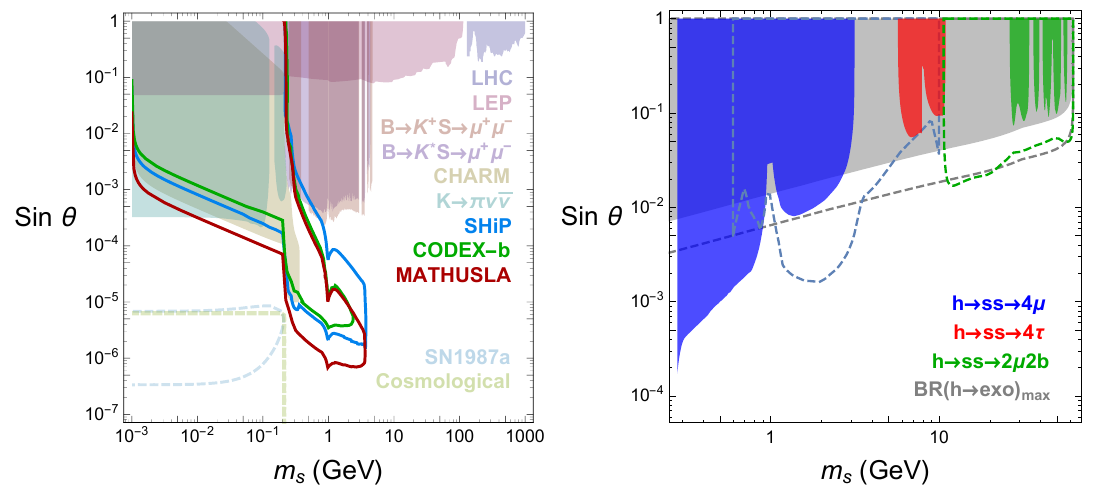
Figure 10 . Left: summary of the current constraints on a dark Higgs portal scalar, s , from: direct searches for heavy scalars decaying to dibosons at LHC [112{114] (blue-gray); Higgs searches at LEP [115{117] (maroon); B + ! K + ( s ! (cid:22) + (cid:22) (cid:0) ) [118] and B ! K (cid:3) ( s ! (cid:22) + (cid:22) (cid:0) ) at LHCb [119] (brown and purple, respectively); K ! (cid:25) + X , with X invisible at E949 [120] (teal); and the CHARM experiment at the CNGS beam-dump [121] (mustard). The blue, green, and red contours show the projected sensitivity for the SHiP, CODEX-b, and MATHUSLA experiments respectively [105{107, 122]. In the lower left corner of the plot we indicate approximate constraints from SN1987A (dashed blue) [17] and late-time entropy injection (dashed green). Right: bounds from exotic Higgs decays for (cid:12)xed m (cid:31) = 2 m s . In blue we show the region probed by searches for h ! ss ( aa ) ! 4 (cid:22) [123], in red the region probed by searches for h ! ss ( aa ) ! 4 (cid:28) [124] and (cid:12)nally in green the region probed by searches for h ! ss ( aa ) ! 2 (cid:22) 2 b [125]. The region shaded in gray produces an exotic branching ratio larger than 34%. The corresponding dashed lines are the possible bounds obtained at the HL-LHC. While constraints are shown for m (cid:31) = 2 m s , all of these bounds on sin (cid:18) scale roughly p proportionally to m (cid:31)